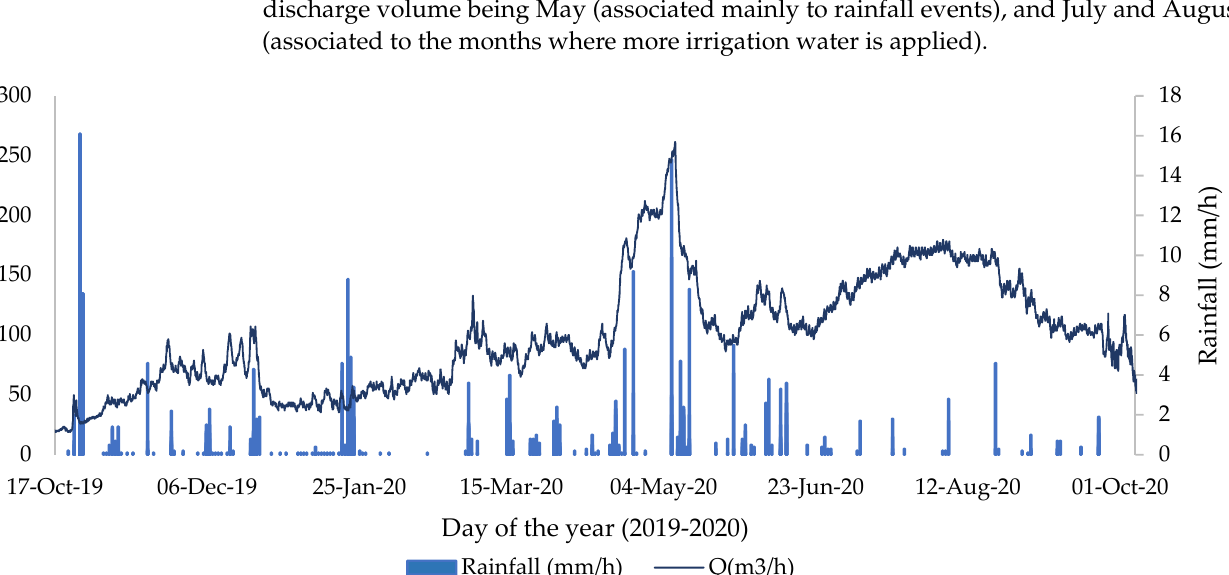
Table 8. Average water level of the monitored outlet (y, mm), average velocity (V, m/s) during each month, average drainage water flow (Q d , m 3 /s) daily drainage average water flow (Q d , m 3 /day) and drainage discharge (Q d , mm/day), total monthly flow (Q m , m 3 /month) and total monthly rainfall (R,